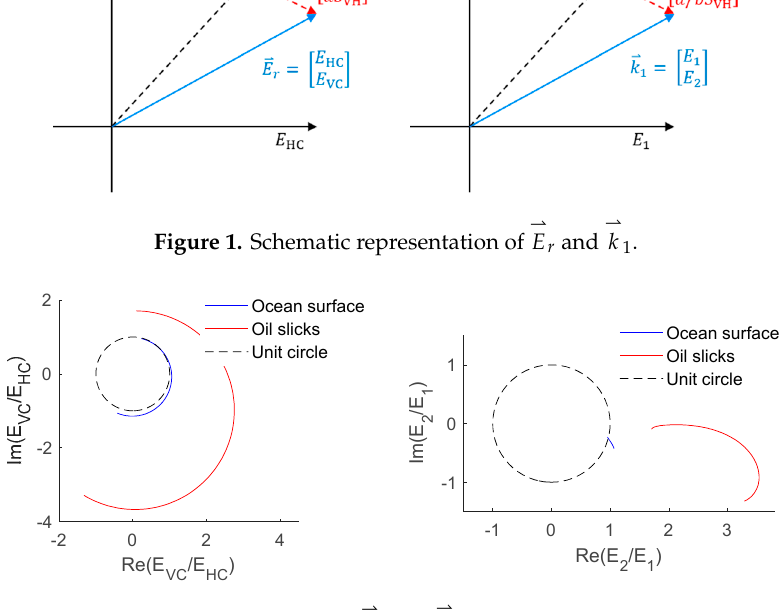
(cid:42) (cid:42) Figure 2. Variation of the polarization ratios of 𝐸(cid:4652)⃑ (cid:3045) and 𝑘(cid:4652)⃑ (cid:2869) with the varying compact polarimetric Figure 2. Variation of the polarization ratios of 𝐸(cid:4652)⃑ (cid:3045) and 𝑘(cid:4652)⃑ (cid:2869) with the varying compact polarimetric E r and k 1 with the varying compact polarimetric (CP) Figure 2. Variation of the polarization ratios of (CP) modes ( 𝜃 = 𝜋/4, 𝜒 ∈ (cid:4670)−𝜋/4,𝜋/4(cid:4671) ) for scatterers from the ocean surface and oil slicks. (CP) modes ( 𝜃 = 𝜋/4, 𝜒 ∈ (cid:4670)−𝜋/4,𝜋/4(cid:4671) ) for scatterers from the ocean surface and oil slicks. modes ( θ = π /4, χ ∈ [ − π /4, π /4 ] ) for scatterers from the ocean surface and oil